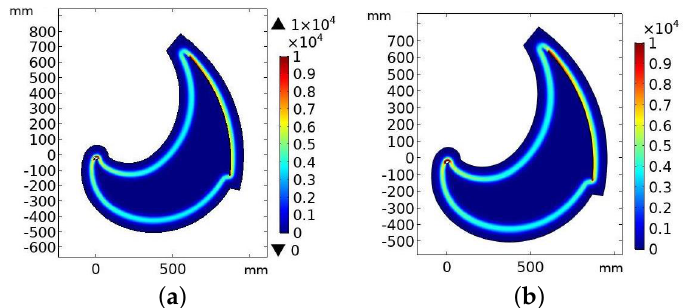
Figure 17. Electric field component E (cid:107) parallel to the middle plane produced by the actual geometry ( a ) vs. the asymmetric sliding short configuration ( b ) at 33.7416 MHz.